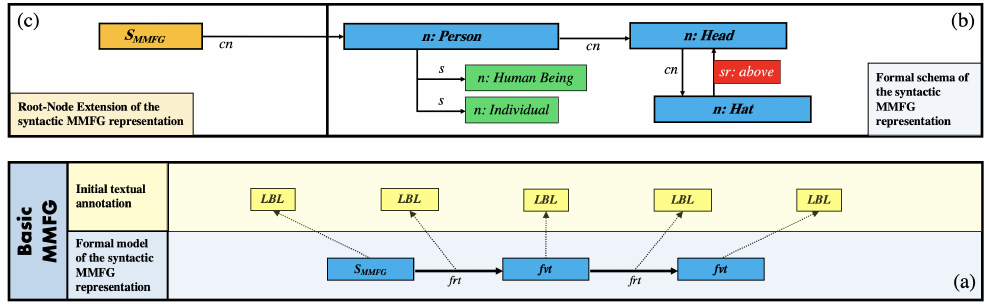
Figure 3. MMFG overview: ( a ) formal model of the syntactic MMFG representation; ( b ) formal syntactic schema of the MMFG representation of MMFG ex ; ( c ) additional starting symbol S MMFG . A basic grammar G MMFG = ( V MMFG , T MMFG , P MMFG , S MMFG ) for the